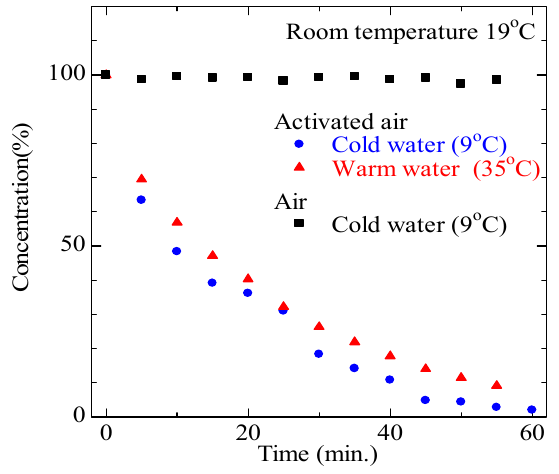
Fig. 11 Time evolution of methylene blue concentration for different initial